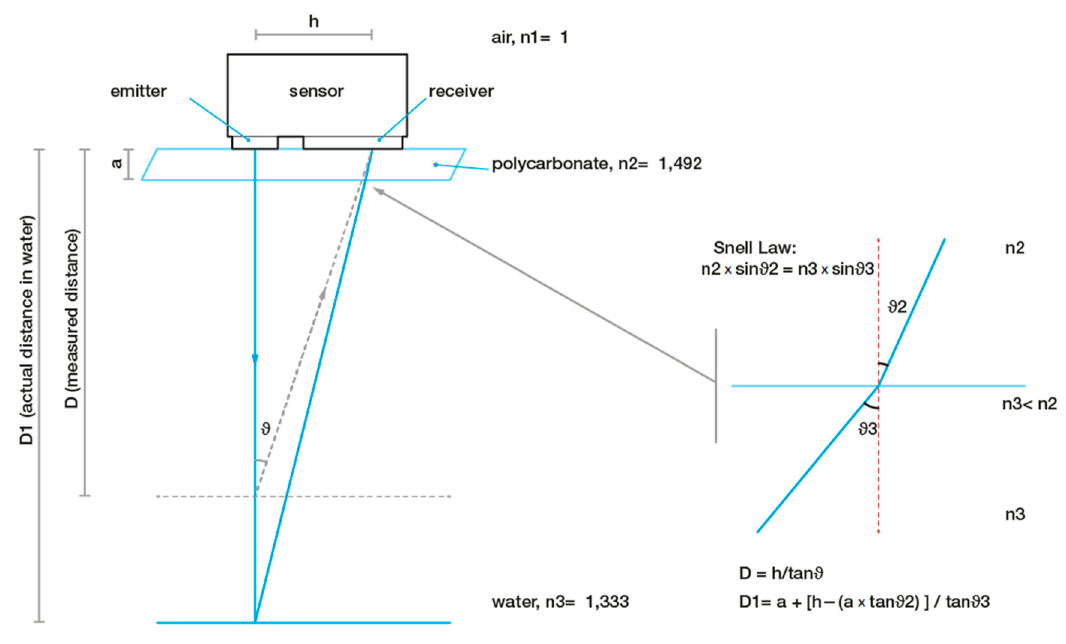
Figure 3. SmartShell: IR optical path and measurement of object distance.